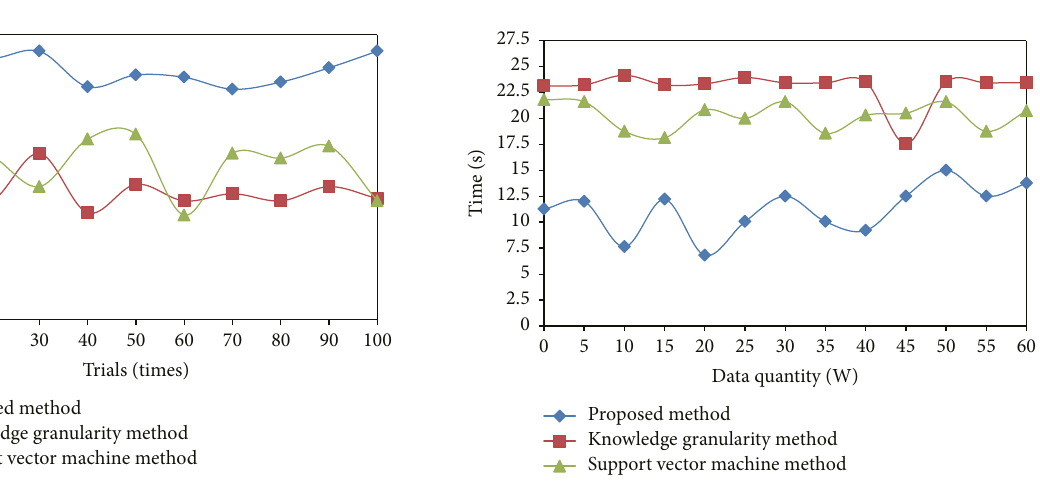
Figure 16: Comparison of outlier data mining